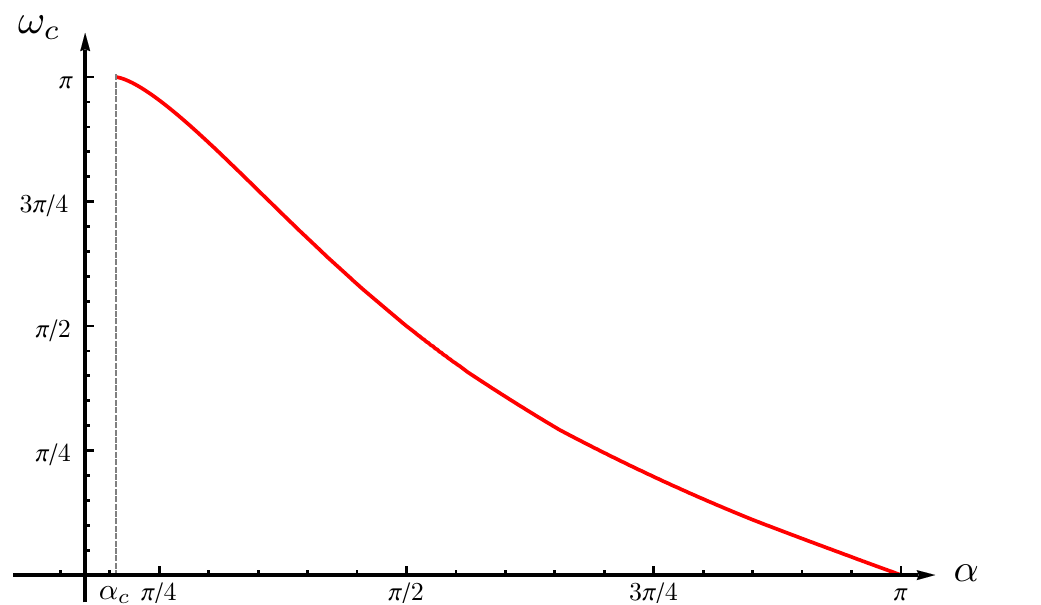
Figure 18 . In(cid:12)nite wedge with only the tip on the boundary and ~ (cid:13) = (cid:13) : the critical opening angle ! c as function of (cid:11) > (cid:11) c . The curve has been found by solving (7.3) numerically. minimal surface ^ (cid:13) is disconnected from Q and it is like the one shown in (cid:12)gure 3, while A for ! > ! it is connected to Q and it looks like the minimal surfaces depicted in (cid:12)gure 16. c The minimal surfaces in (cid:12)gure 16 are prototypical examples of the surfaces employed to (cid:12)nd the numerical data corresponding to the empty circles in (cid:12)gure